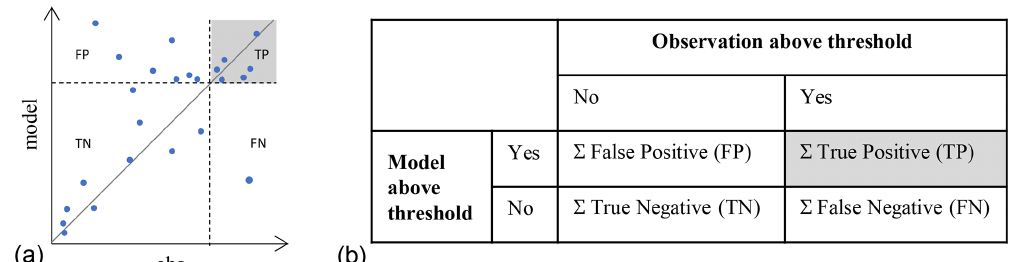
Figure 5. Contingency tables (b) are used to categorise each event according to whether it is above or below a given threshold. The solid line (a) is the 1 : 1 line, the blue points are the calculated signatures for each event (modelled vs. observed value), and the dotted lines represent the threshold used to distinguish positives from negatives.